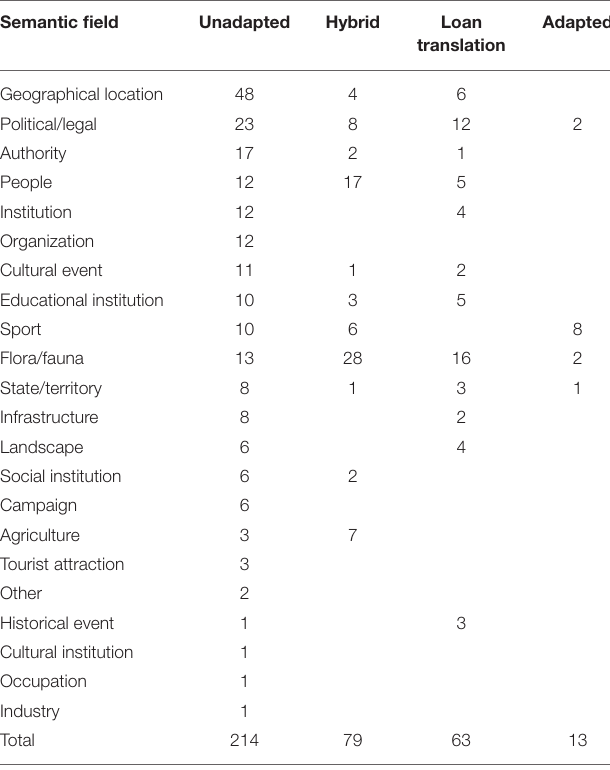
TABLE 5 | Semantic field by borrowing type with total tokens of 50 or more. Semantic field Unadapted Hybrid Loan